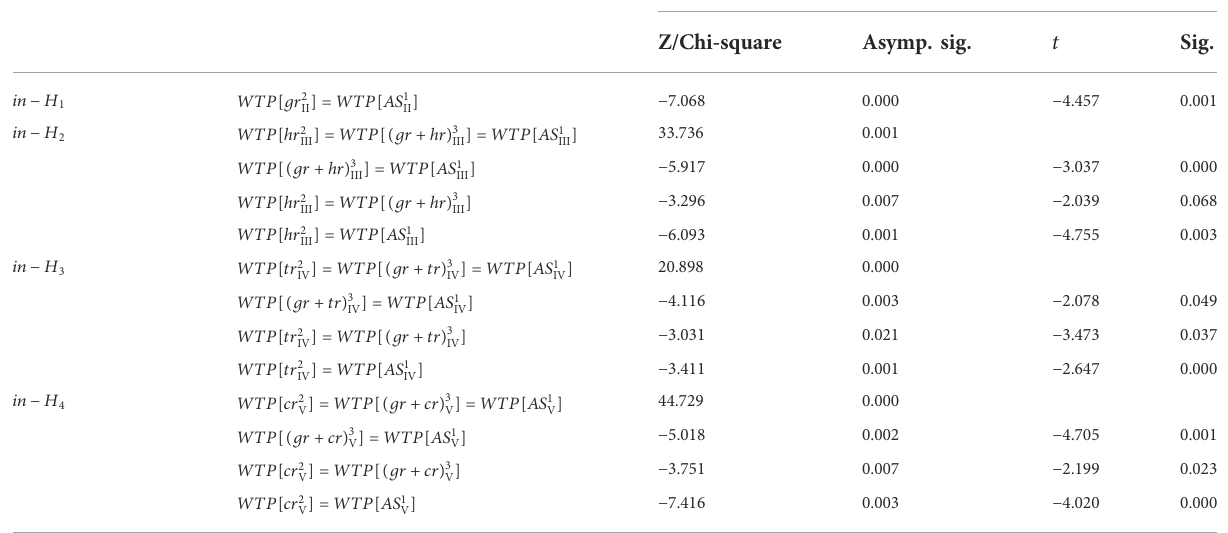
TABLE 8 Results of internal scope